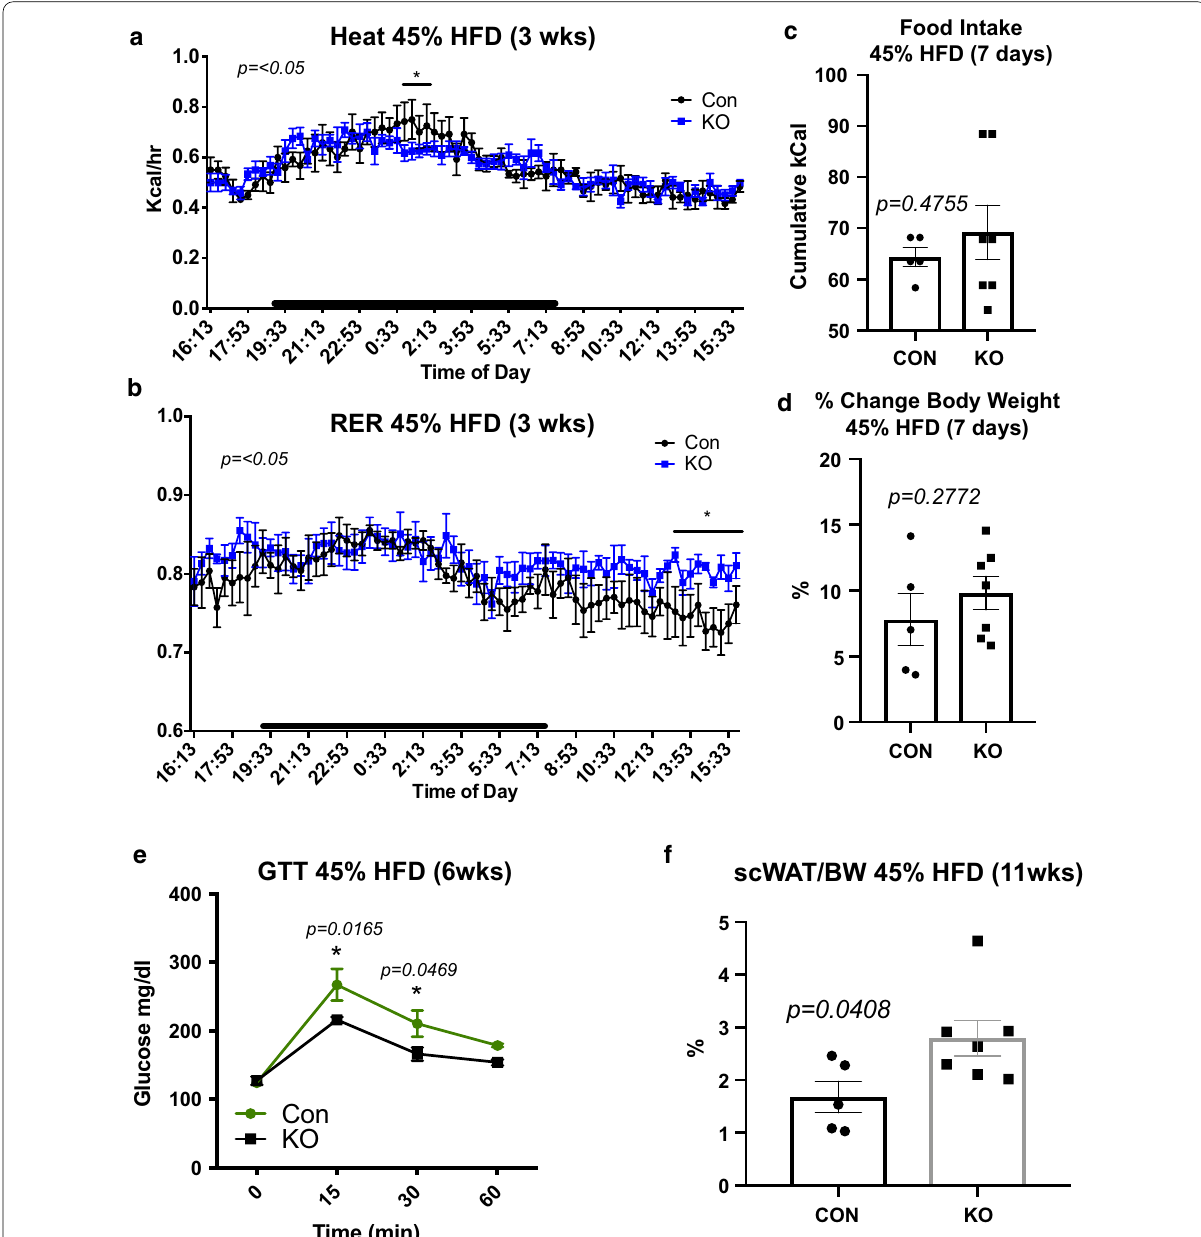
Fig. 3 LysMCre ± ::BDNF − / − (KO) showed accelerated fat accumulation on a 45% HFD. Adult (25 week old) male LysMCre − / − ::BDNF fl/fl (CON) and LysMCre ± ::BDNF −/− (KO) were challenged with a 45% HFD for 3 weeks before undergoing physiological assessment in metabolic cages ( a , b ). Energy expenditure as measured by heat was lower for KO versus CON only for a short period during the dark cycle, *p 0.05 ( a ). Respiratory exchange ≤ as a ratio (RER) between the two groups, indicated greater use of carbohydrates for fuel by KO animals during the light cycle, p 0.05 ( b ). Data ≤ presented as waveform analysis of measurements taken at 15 min increments for 3 days. Time of day is indicated on the x‑axis, and animals were maintained on a 12 h light/dark cycle (black bars indicate dark cycle). Data analyzed by two‑way repeated measures ANOVA with Fisher’s LSD test; N 4 per group. Adult (25 week old) male CON and KO animals were placed on a 45% HFD, daily food intake (represented as cumulative food = intake), p 0.4755 ( c ) was measured for the 1st week of HFD feeding. Percent change in body weight p 0.2772 ( d ) was measured for the first = = 7 days of HFD feeding. Data were analyzed by two‑tailed Student’s T ‑Test, N 5 CON, N 7 KO. Glucose tolerance testing was performed at 6 weeks = = of HFD feeding, p 0.0165 at 15 min, p 0.0469 at 30 min ( e ). Data were analyzed by Two‑way ANOVA, with Tukey’s multiple comparisons test, = = N 5 CON, N 5 KO. Adiposity was measured for CON and KO animals after 11 weeks of HFD feeding as a percentage of scWAT over body weight = = p 0.0408 ( f ). Data were analyzed by two‑tailed Student’s T ‑Test, N 5 CON, N 7 KO. For all error bars are = = =